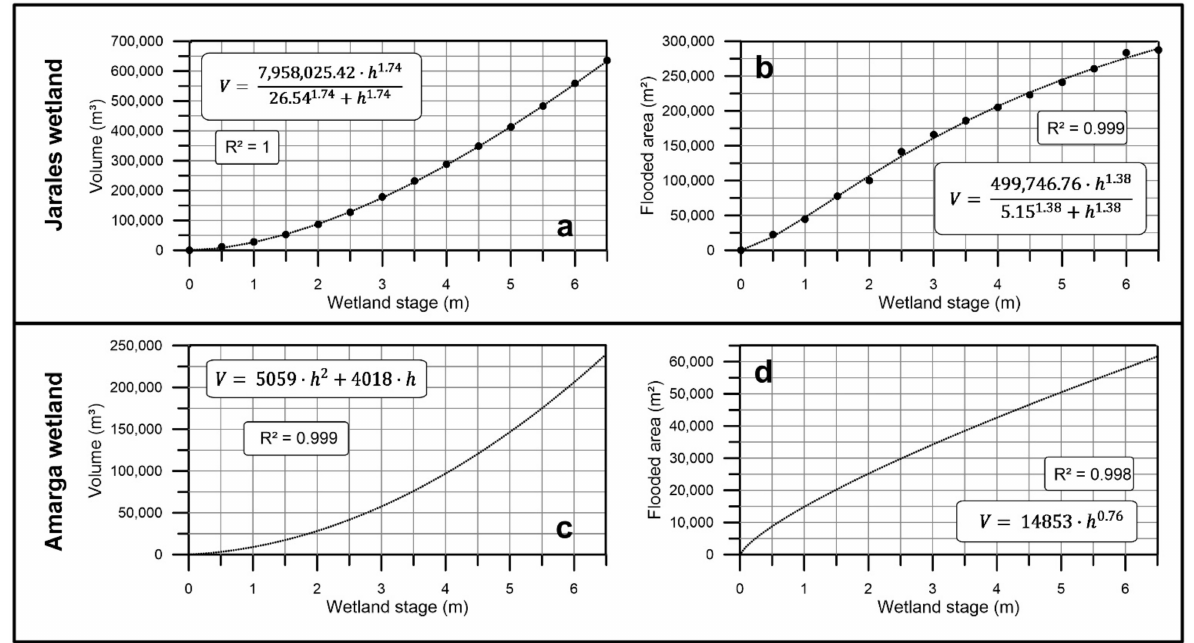
Figure 3. Wetland stage ( h ) versus stored volume ( V ) and flooding area ( A ) of the Jarales ( a , b ) and Amarga wetlands ( c , d ). The equations of the Amarga wetland were obtained from Aljibe Consultores